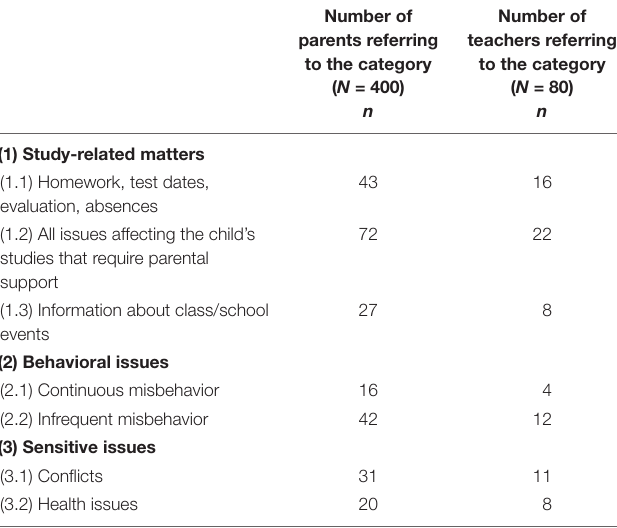
TABLE 2 | The views and expectations of parents and teachers concerning the contents of DC.